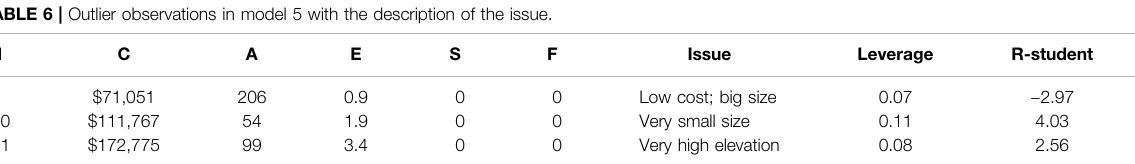
TABLE 6 | Outlier observations in model 5 with the description of the issue.